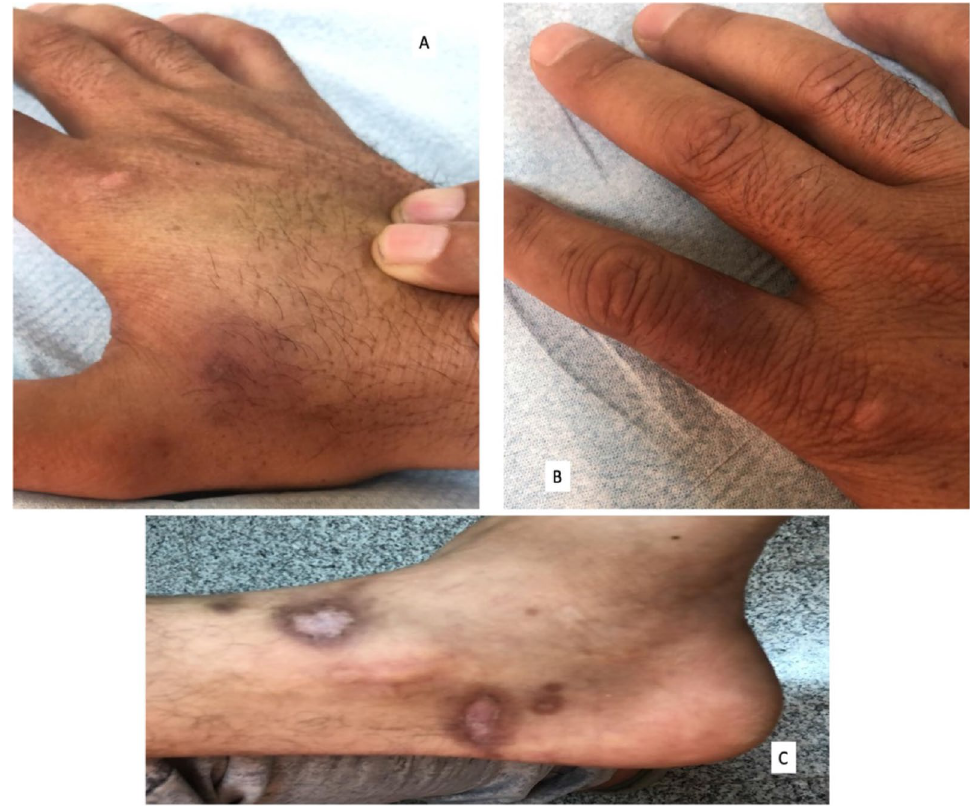
Figure 6. Resolution of the CL lesions. A-C: Post inflammatory hyperpigmentation and scaring in a different exposed body sites after a full course of treatment. (Once weekly 0.5 mL per lesion (50 mg) intralesional sodium stibogluconate for 6 weeks